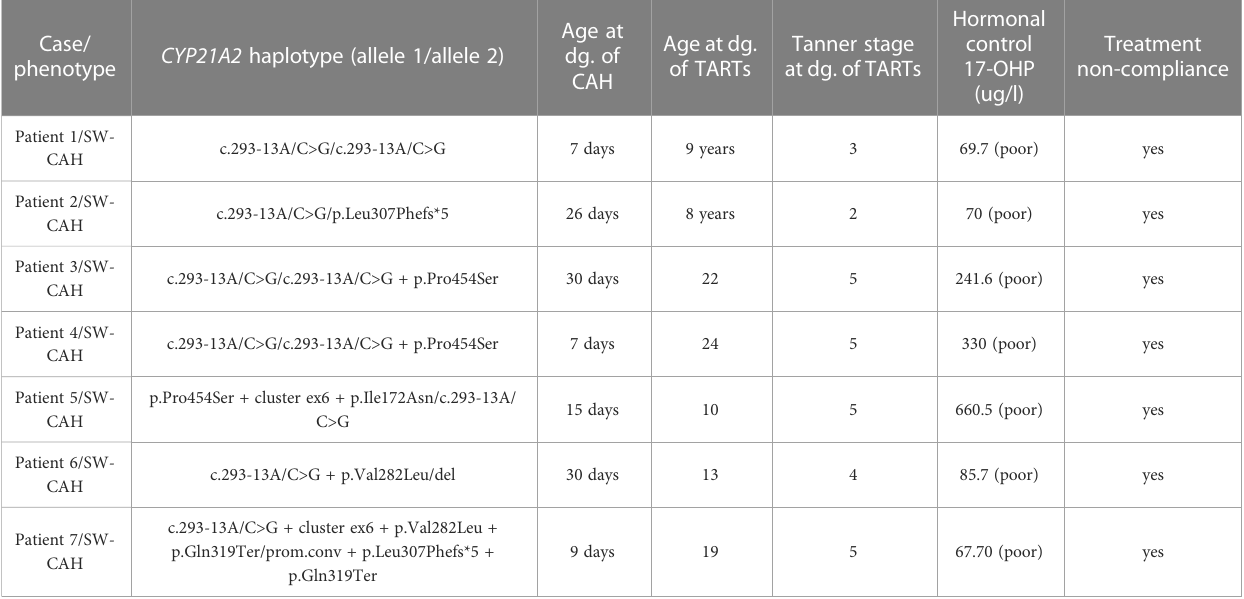
TABLE 3 Characteristics of patients with